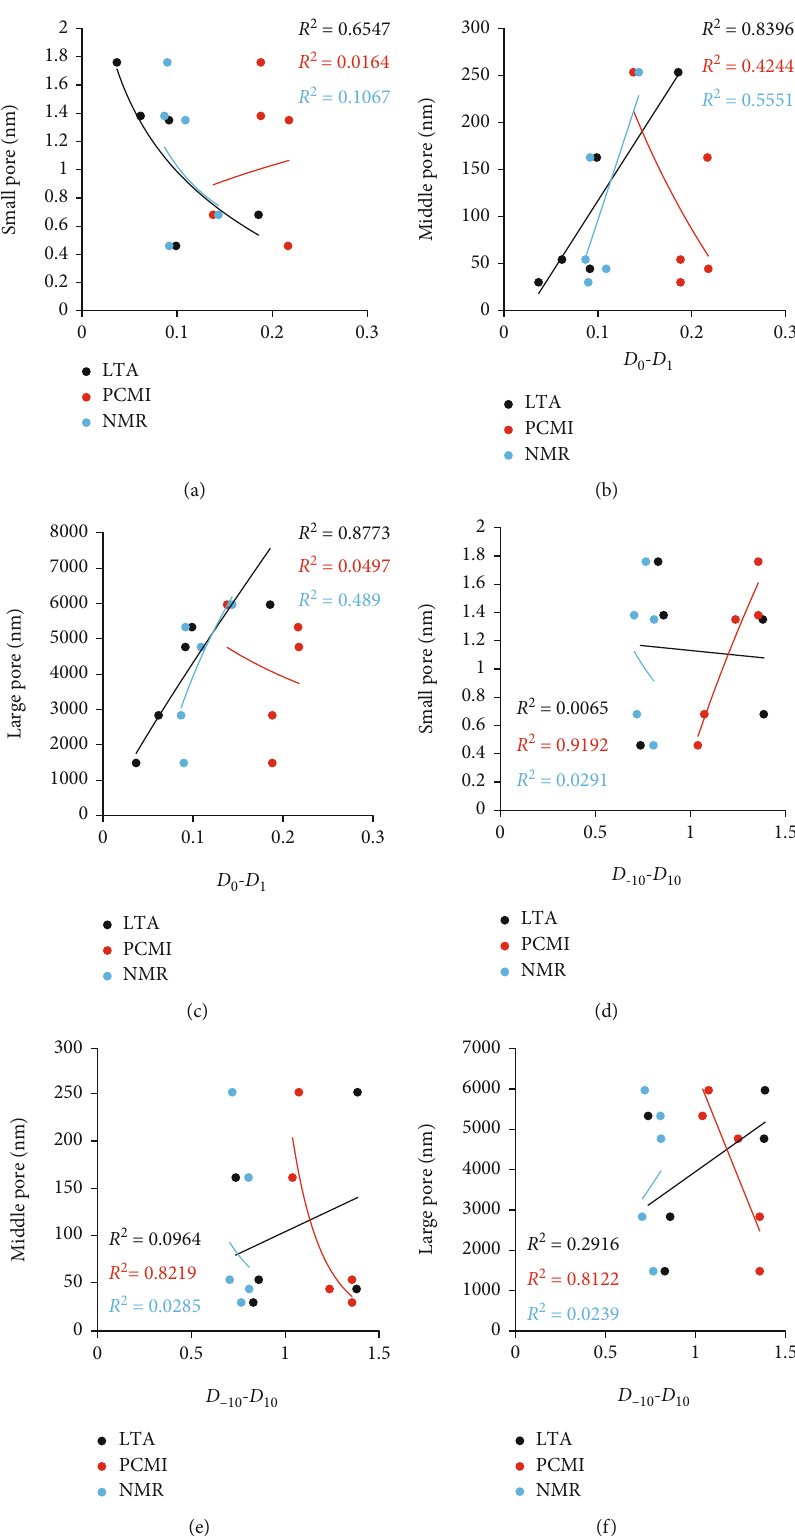
-D vs (a) average small pore radius; (b) average middle 0 1